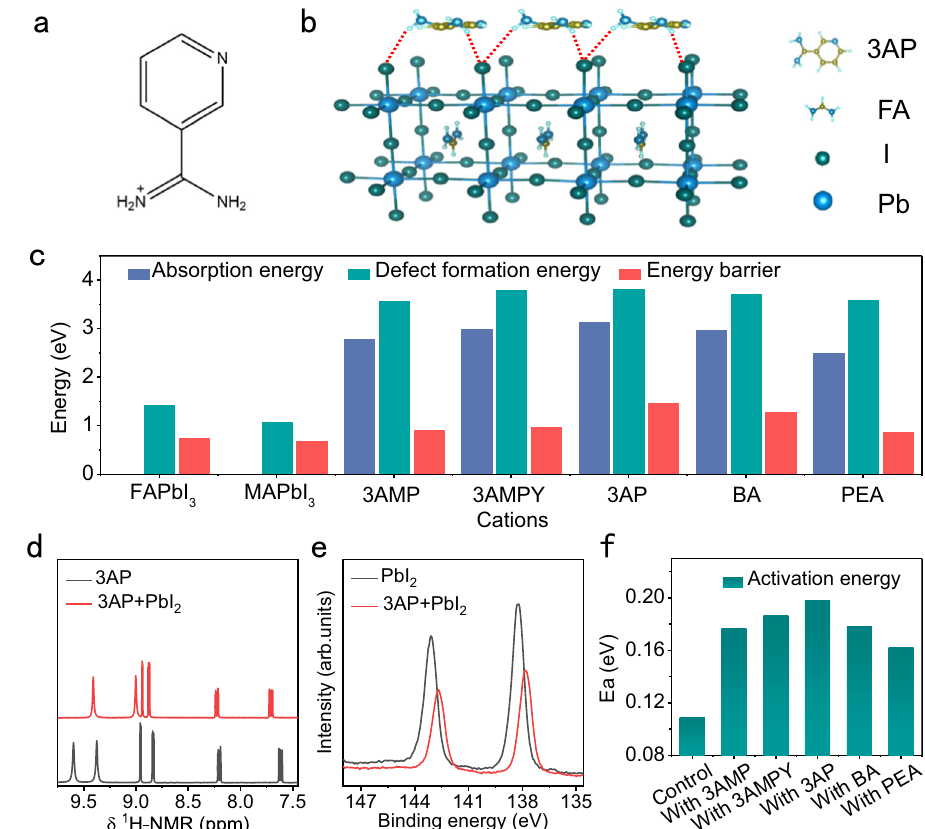
Fig. 1 | 3AP – perovskite coordination. a Chemical structure of the 3AP + ion. b SupercellconstructedforDFTcalculations,inwhich3APmoleculesareadsorbed on the FAPbI 3 (001) surface via FAI terminal groups. c Absorption energies of ligands on the perovskite surface, formation energies of I − vacancies in the per- ovskite structure, and migration energy barriers of I − vacancies in the perovskite lattice calculated for the perovskite systems with 3AMP, 3AMPY, 3AP, BA, and PEA